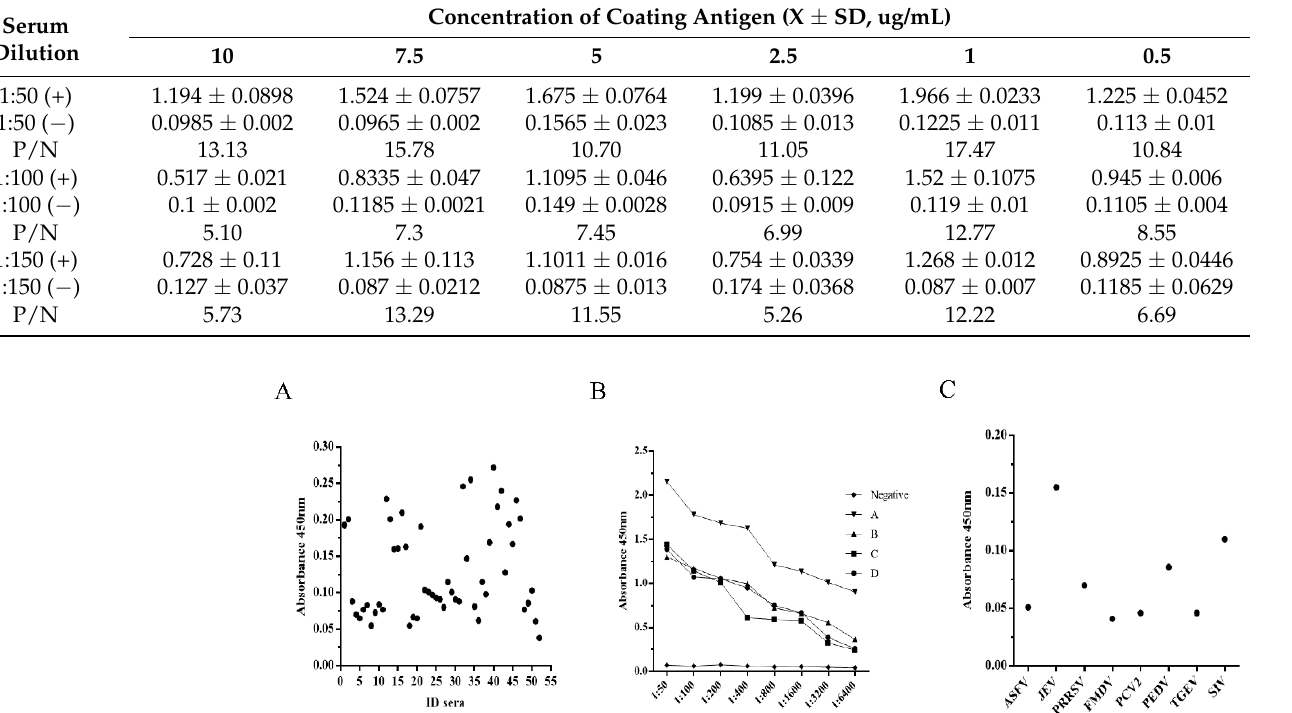
Figure 5. Characterization of PPV-VLP-ELISA. ( A ) Determination of the cut-off value for PPV-VLP- ELISA. ( B ) Determination of the sensitivity of PPV-VLP-ELISA. ( C ) Determination of the specificity of PPV-VLP-ELISA.